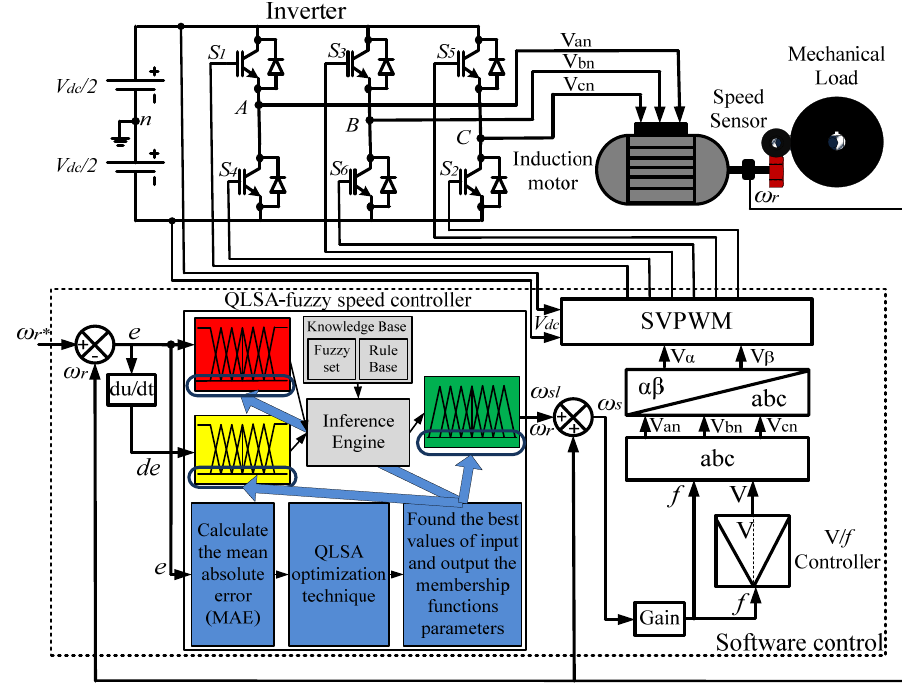
Figure 6. Block diagram of the proposed quantum-behaved lightning search-fuzzy (QLSAF) speed controller for three-phase induction motor (TIM).